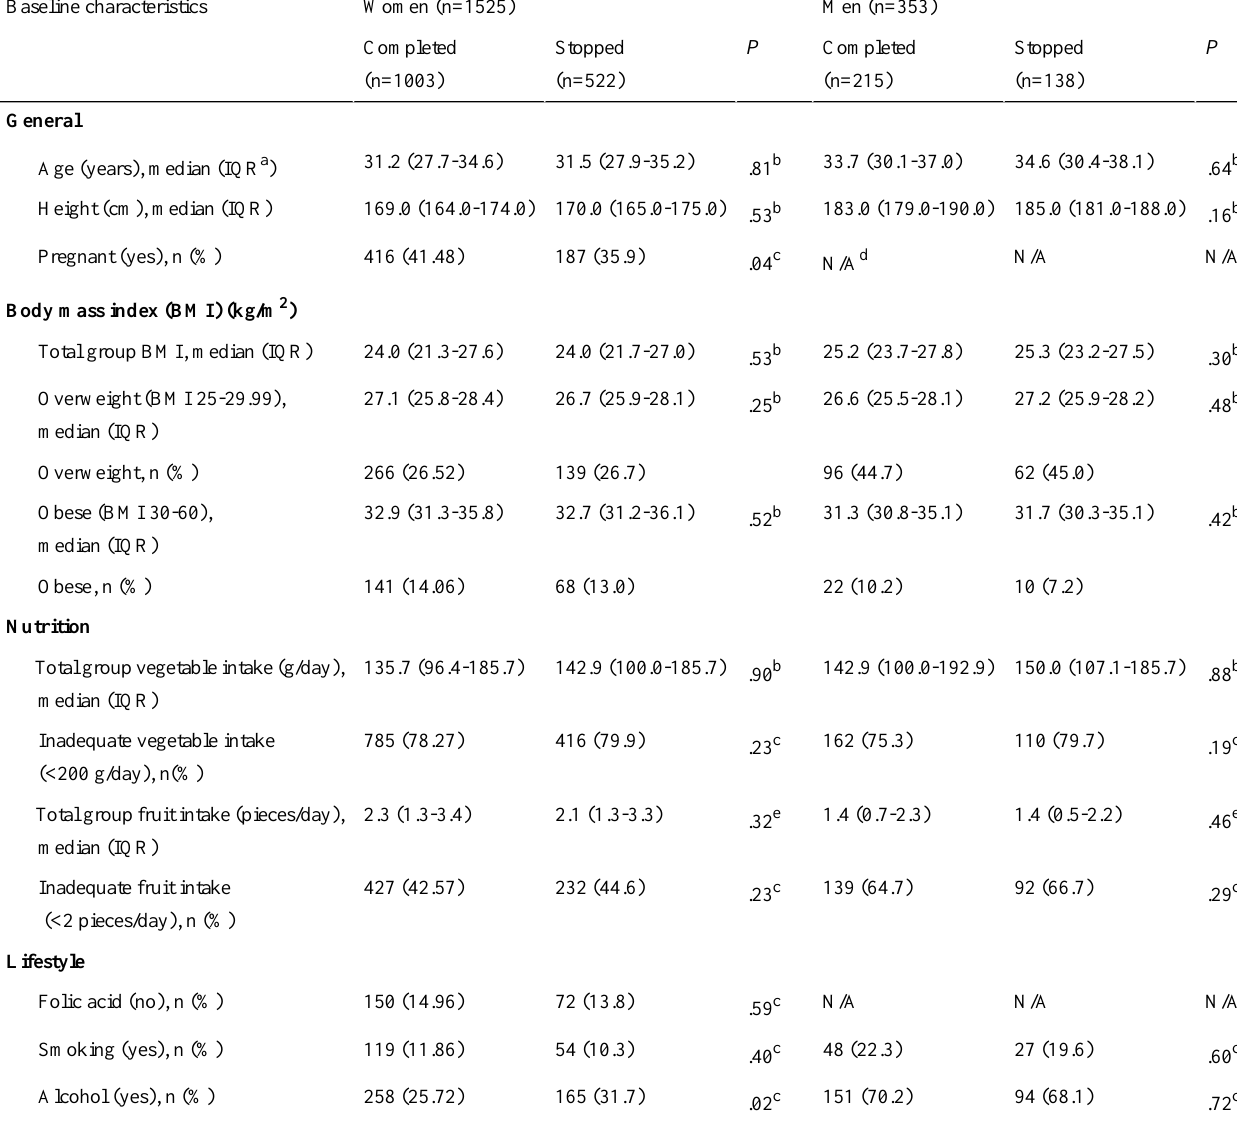
Table 1. Baseline characteristics of